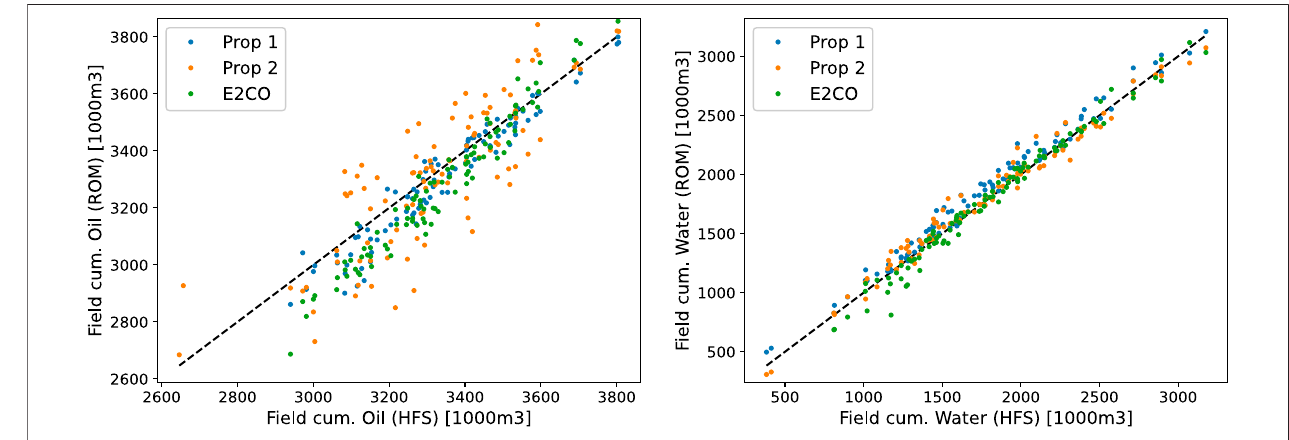
FIGURE 18 | Cumulative oil (left plot) and water (right plot) production.